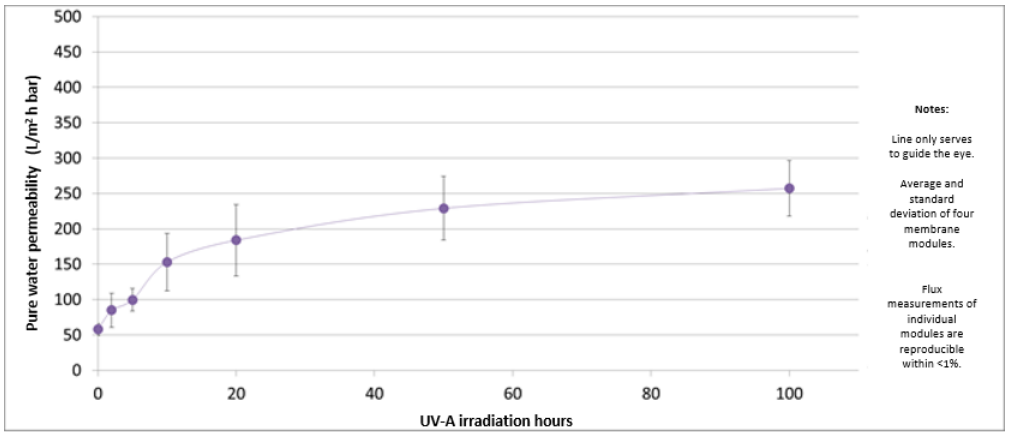
Figure 7. Permeability values of the PES-TiO 2 hollow fiber membranes as a function of UV irradiation time.